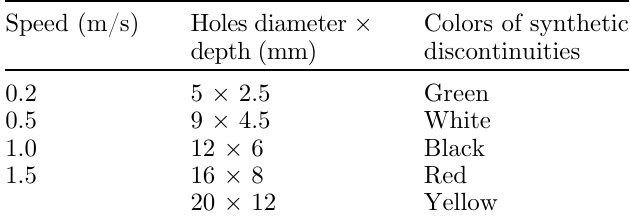
Table 1. Test parameters.